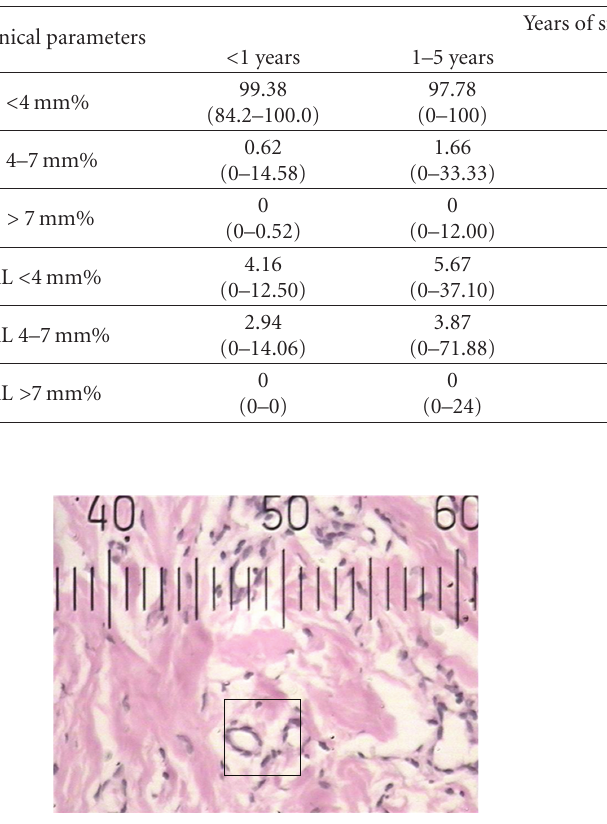
Table 15: Pattern of clinical parameters with years of smoking.